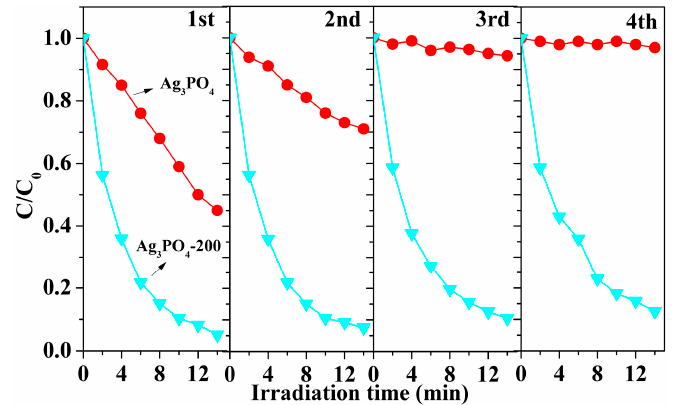
Figure 2. Cycling curves of photocatalytic degradation of MB solution in the presence of pristine Ag 3 PO 4 and Ag 3 PO 4 -200, respectively.